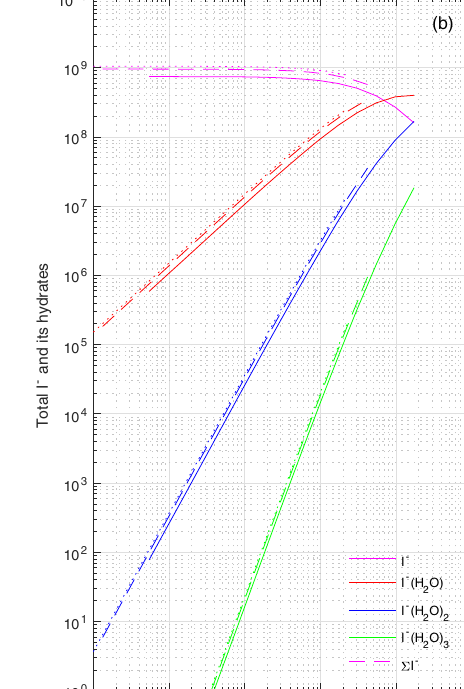
Figure 11. (a) Oxygen anion speciation: O − at sample pressures of 120 (dotted), 300 (dashed) and 1013 (solid) hPa. (b) As in panel (a) except for iodide speciation: I − , I − ( H 2 O ) , I − ( H 2 O ) 2 and I − ( H 2 O ) 3